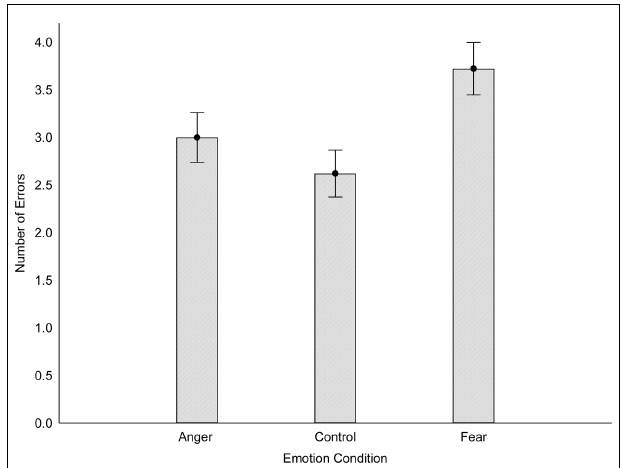
FIGURE 3 | Performance on the two-point discrimination task as a function of emotion condition (Study 2). Higher scores indicate poorer tactile sensitivity. Error bars reflect standard